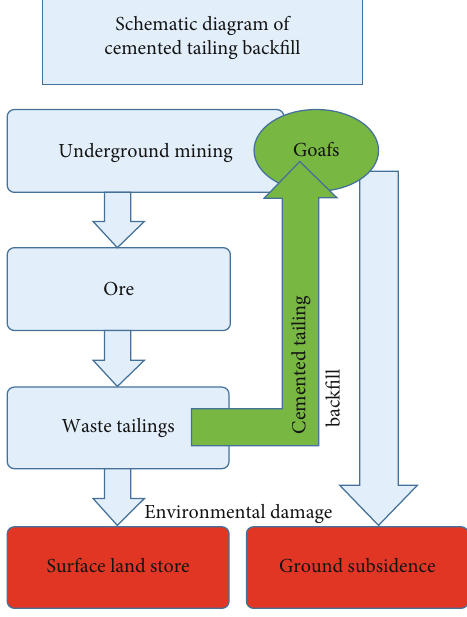
Figure 1: Schematic diagram of cemented tailing back fi